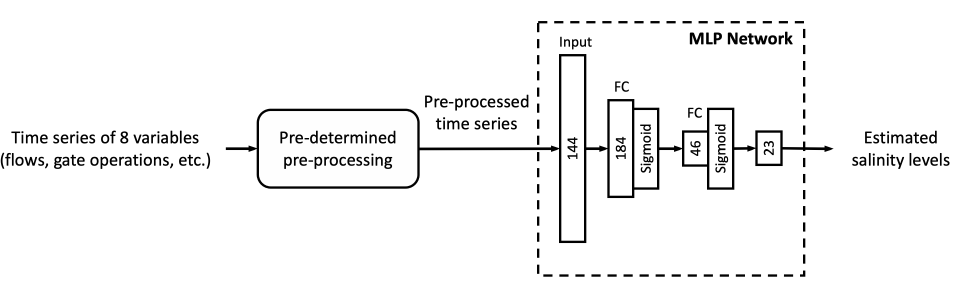
Figure A1. Diagram of the MLP network from [29]. The number in the input layer denotes input shape and those in the subsequent FC layers represent the numbers of neurons of the layers.